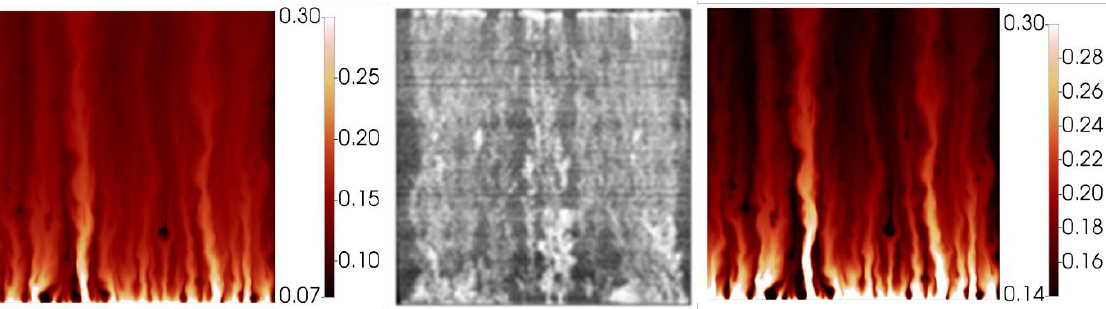
Figure 8. Experimental vs. simulated finger patterns during displacement of 7000 mPa.s oil.